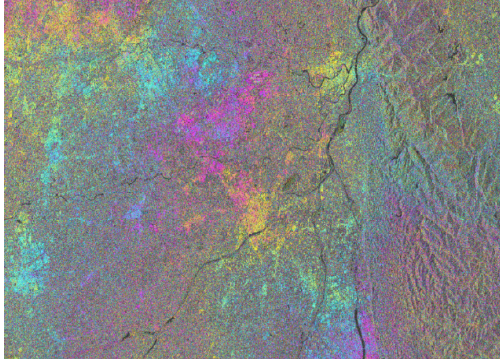
Figure 10. Sentinel-1 flattened interferogram.